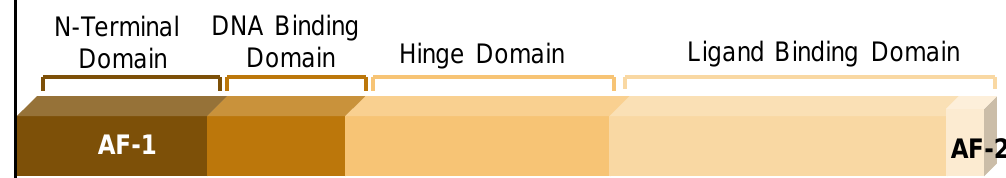
Figure 4. Schematic structure of a typical nuclear receptor (NR). The modular structure of NRs includes an N-terminal region, responsible for the ligand-independent activation function (AF-1), a DNA-binding domain, a hinge domain and a ligand-binding pocket responsible for the ligand-dependent activation function (AF-2).